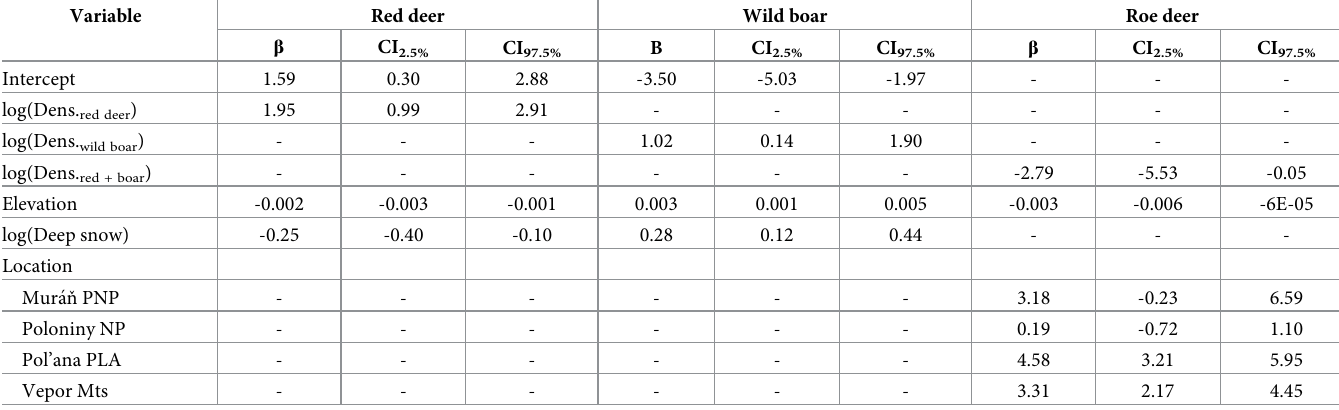
Table 2. Latent selection difference (LSD). Coefficients and confidence intervals of the top models for the main prey species as red deer, wild boar and roe deer, based on wolf scats collected during 2015–2017 in the Slovak Carpathians. Models describe the probability that one prey species would be selected in winter by wolves over another two prey